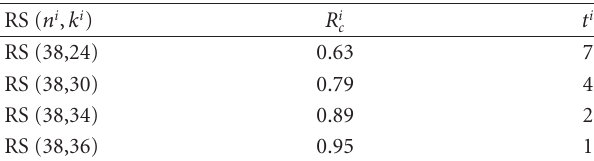
Table 2: Actual parameters for Reed-Solomon UEP coding at P b = 10 − 3 for u 1 ( τ )